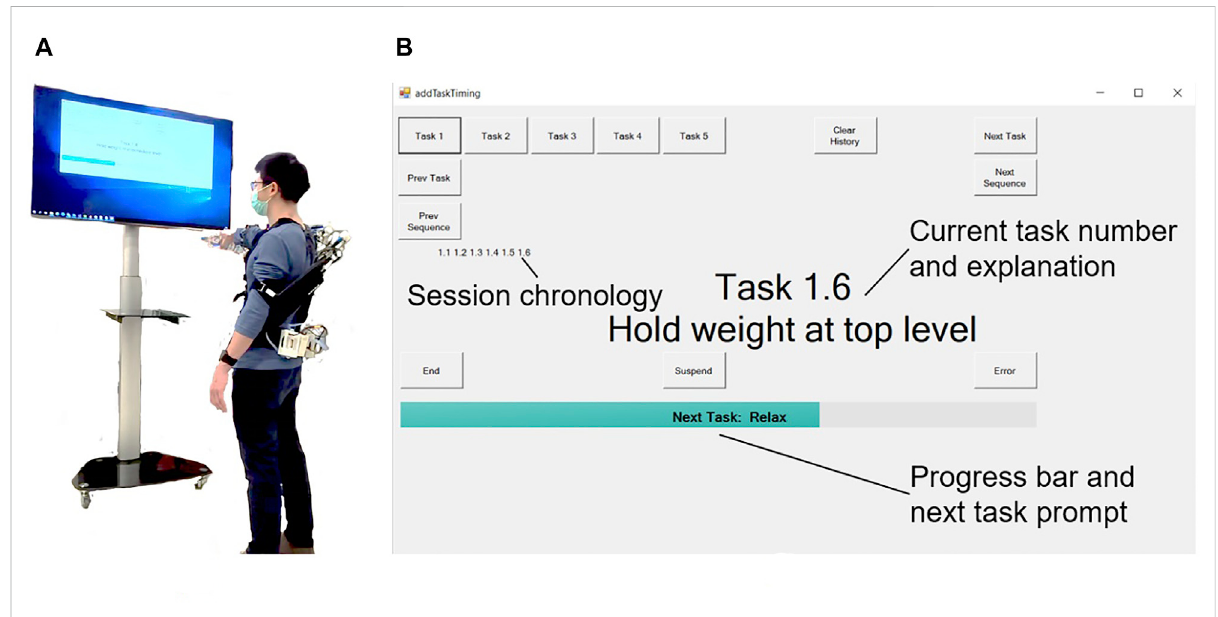
FIGURE 6 Experimental setup. (A) Participant performing the experiment. (B) GUI.